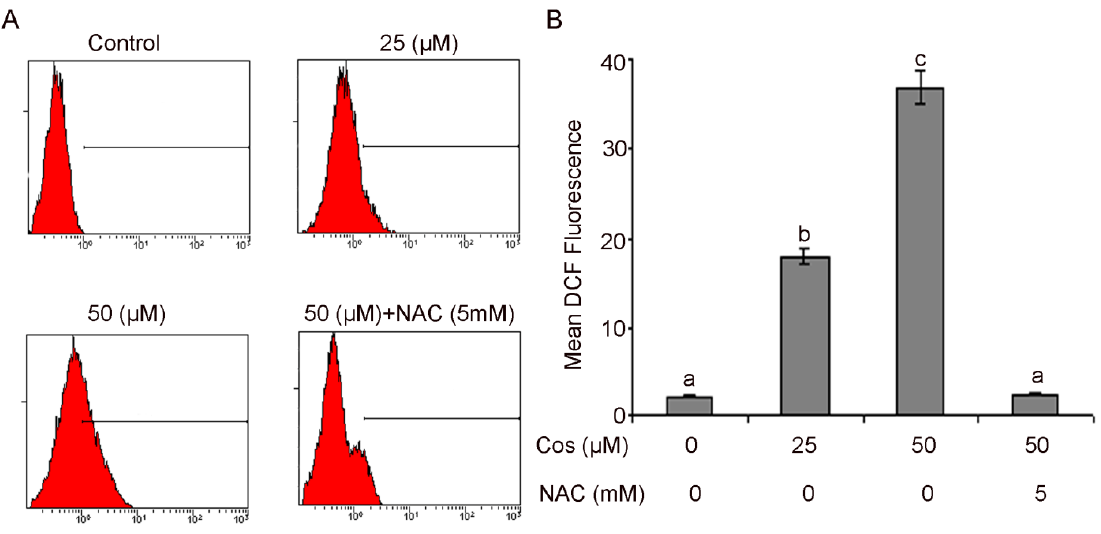
Figure 7. Flow cytometry analysis of ROS generation. ( A ) T24 cells were treated with 25 and 50 µM costunolide in the presence or absence of 5 mM NAC for 24 h. ( B ) Data are expressed as mean ± SD (n = 3). Columns not sharing the same superscript letter differ significantly ( p <